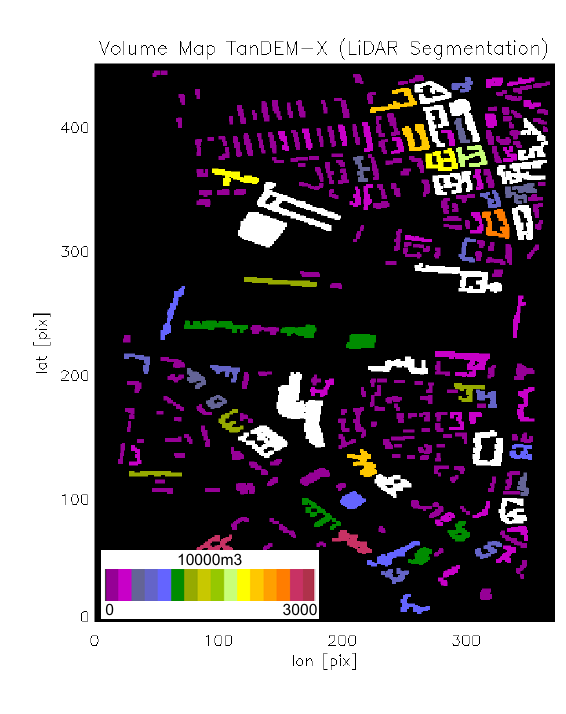
Figure 3: Volume map derived from TanDEM-X data using the LiDAR segmentation result.